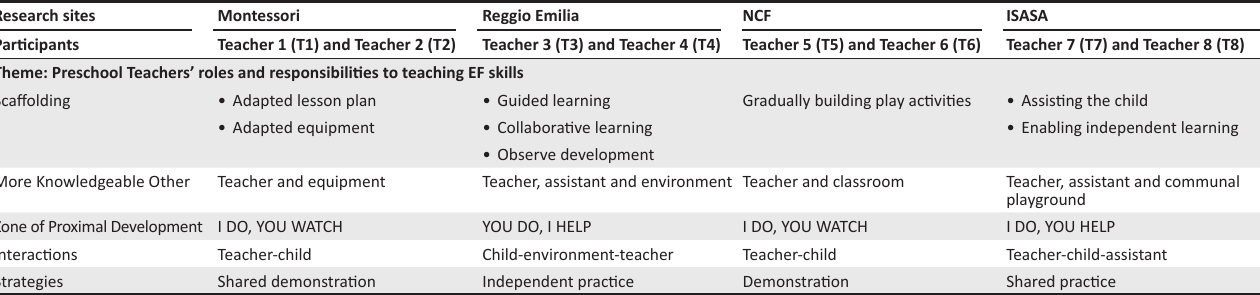
TABLE 2: Theoretical concepts infused participants and research sites. Research